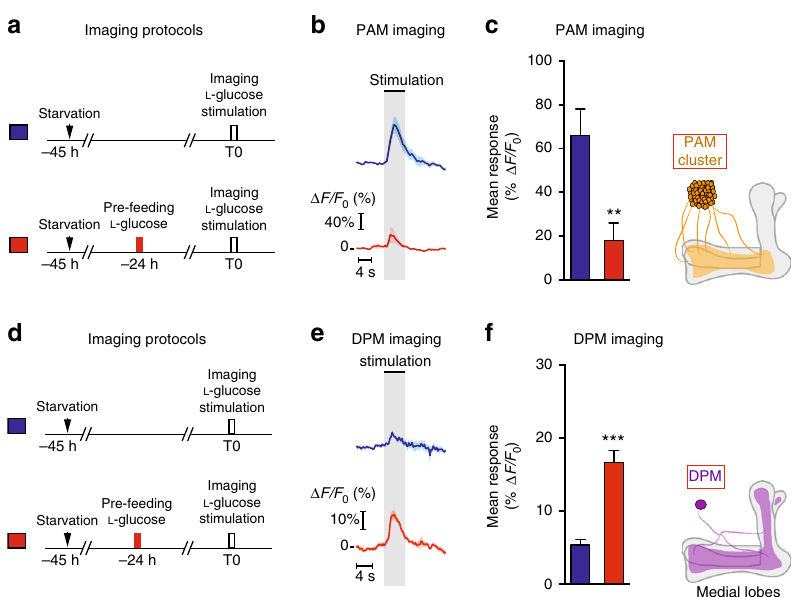
Fig. 4 PAM dopaminergic neurons display lower calcium responses while DPM neurons display a higher calcium response to NAS after pre-feeding. a Pre- feeding protocol used before the imaging experiment: fl ies were pre-fed or not with L -glucose for 1 min, 24 h before L -glucose stimulation under